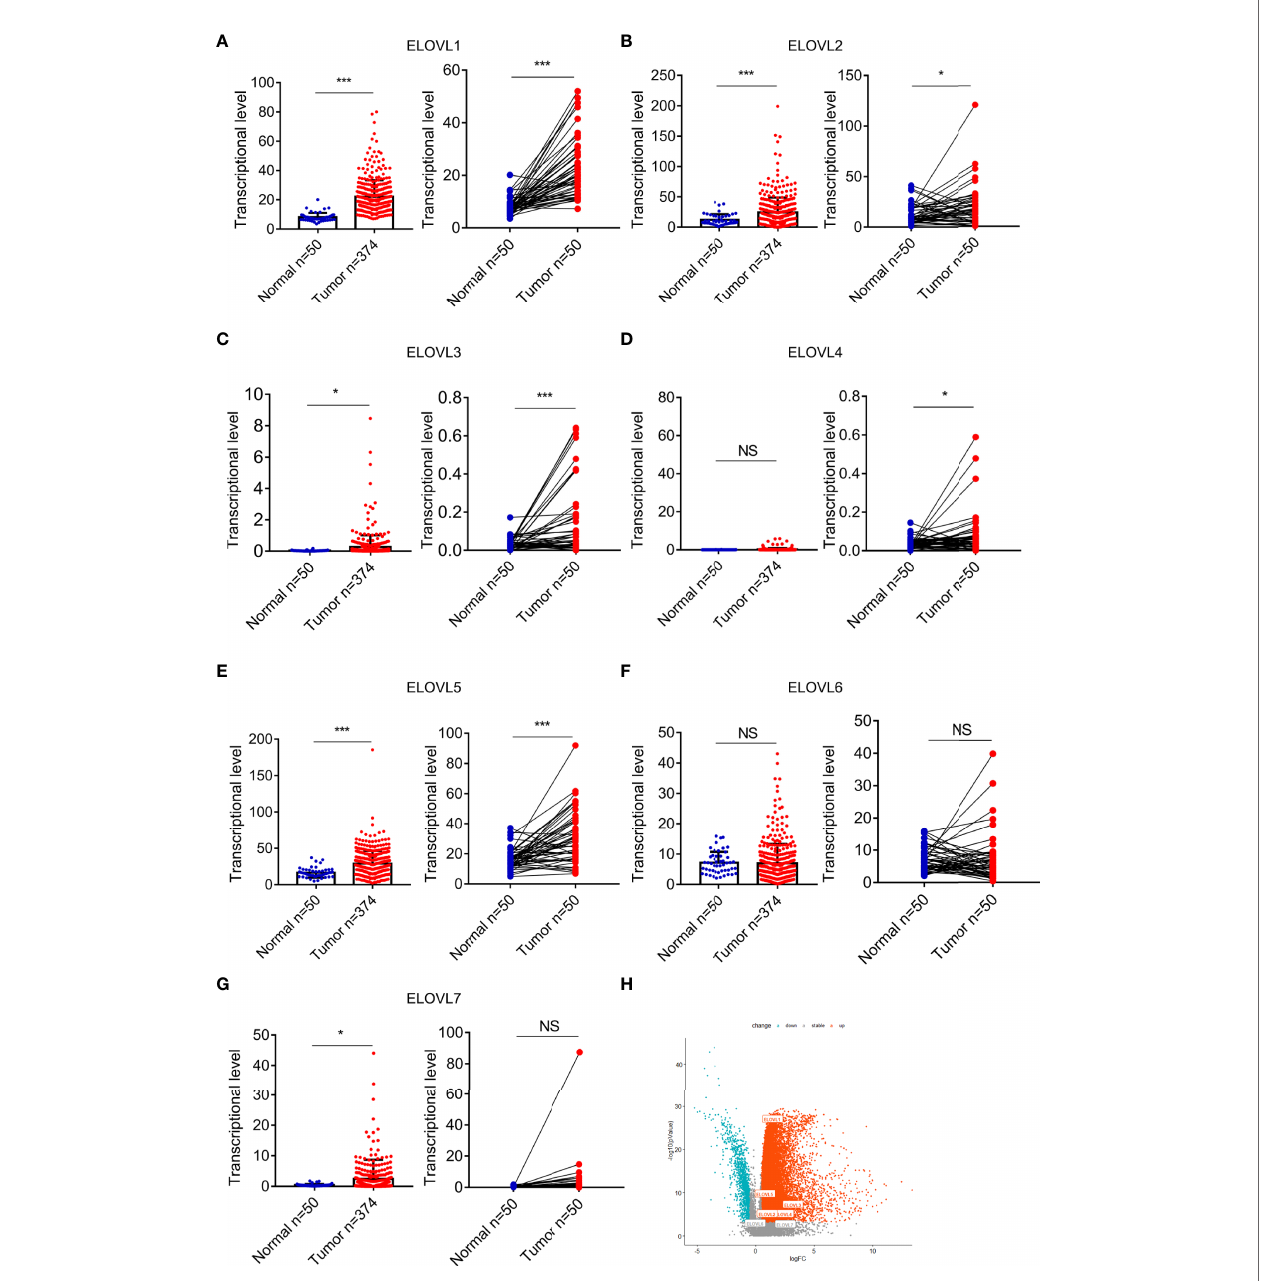
FIGURE 2 | The mRNA expression of ELOVLs in HCC in the TCGA database. (A – G) ELOVLs were increased in HCC than the normal adjacent liver tissues except the ELOVL6. The left sub fi gures were the relative expression of the ELOVLs between the HCC and normal liver tissues from TCGA, and the right sub fi gures were the pairwise boxplot of the ELOVLs expression between the paired normal and HCC liver tissues in TCGA dataset. (H) The volcano plots of the expression of ELOVLs in HCC. *P < 0.05 and ***P < 0.001. NS, Not Signi fi